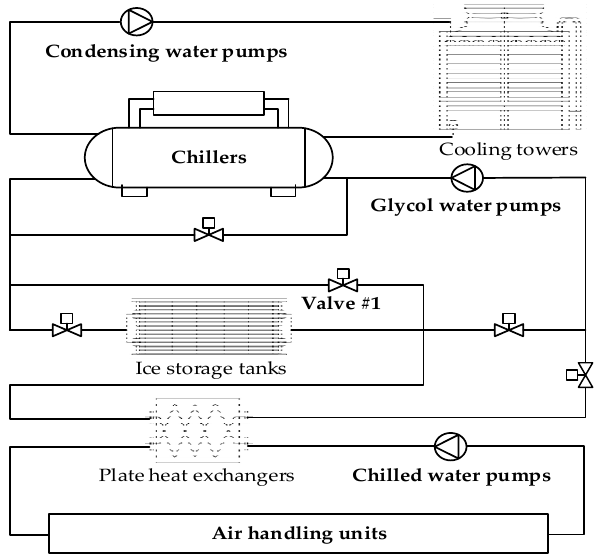
Figure 3. Schematic of the air-conditioning system involved in the case study.